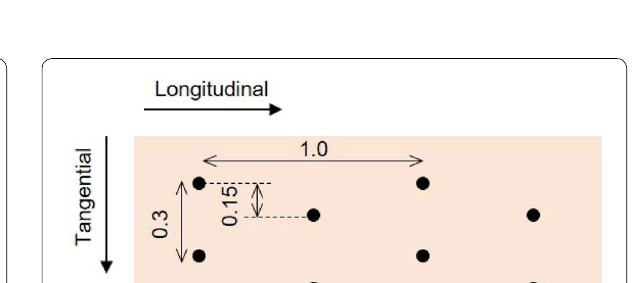
standard deviation ±